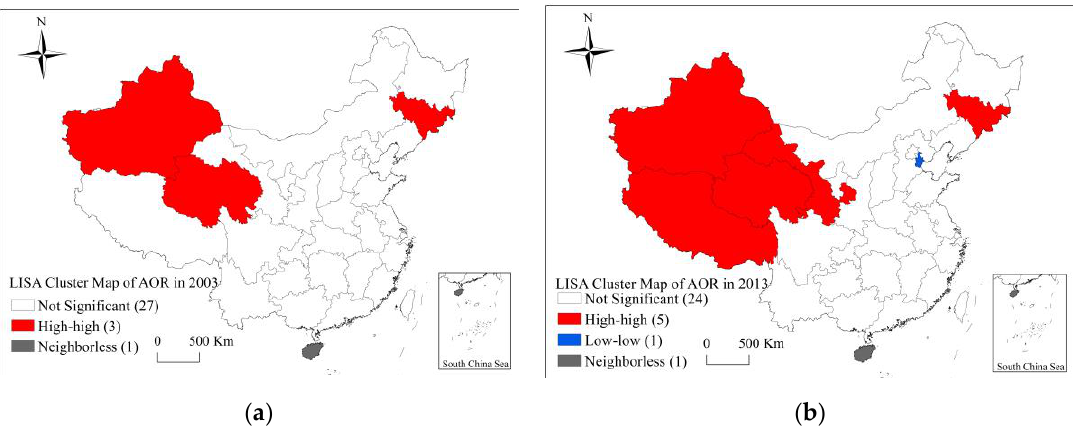
Figure 4. Local identifications of spatial association (LISA) cluster map: ( a ) AOR of natural wetlands in 2003; ( b ) AOR of natural wetlands in 2013.